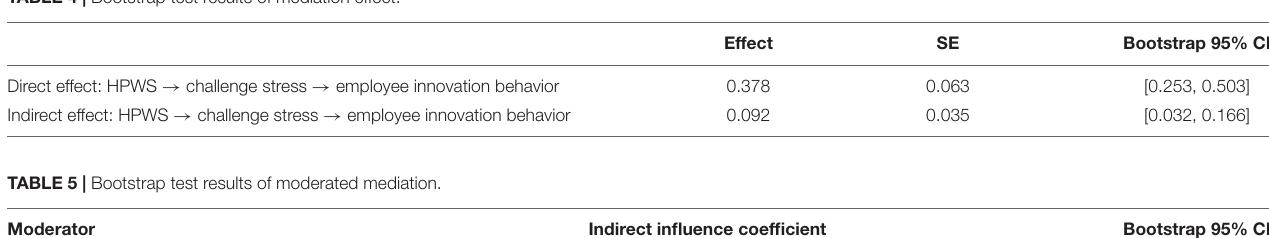
TABLE 4 | Bootstrap test results of mediation effect.